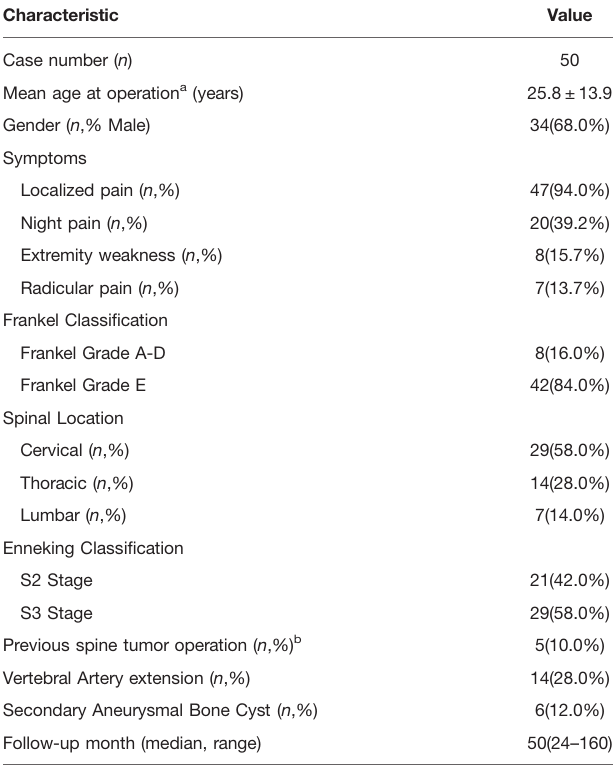
TABLE 1 | Demographic and clinical characteristics of the patients.